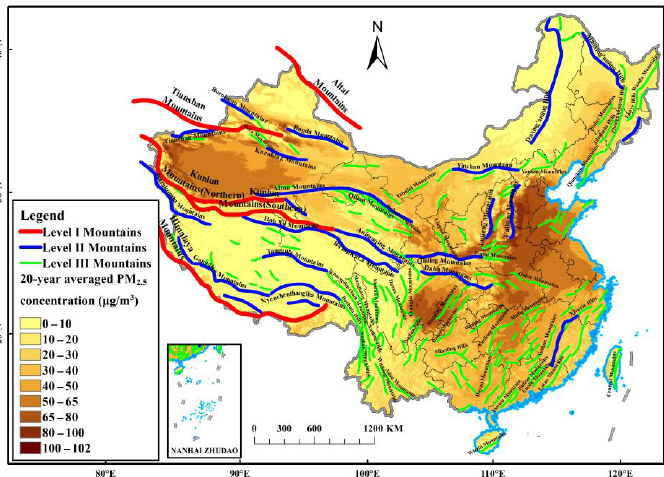
Figure 3. The spatial distribution of the average PM 2.5 concentration during 2000–2019. This result is calculated by averaging all annual PM 2.5 concentration data during 2000–2019 over China.